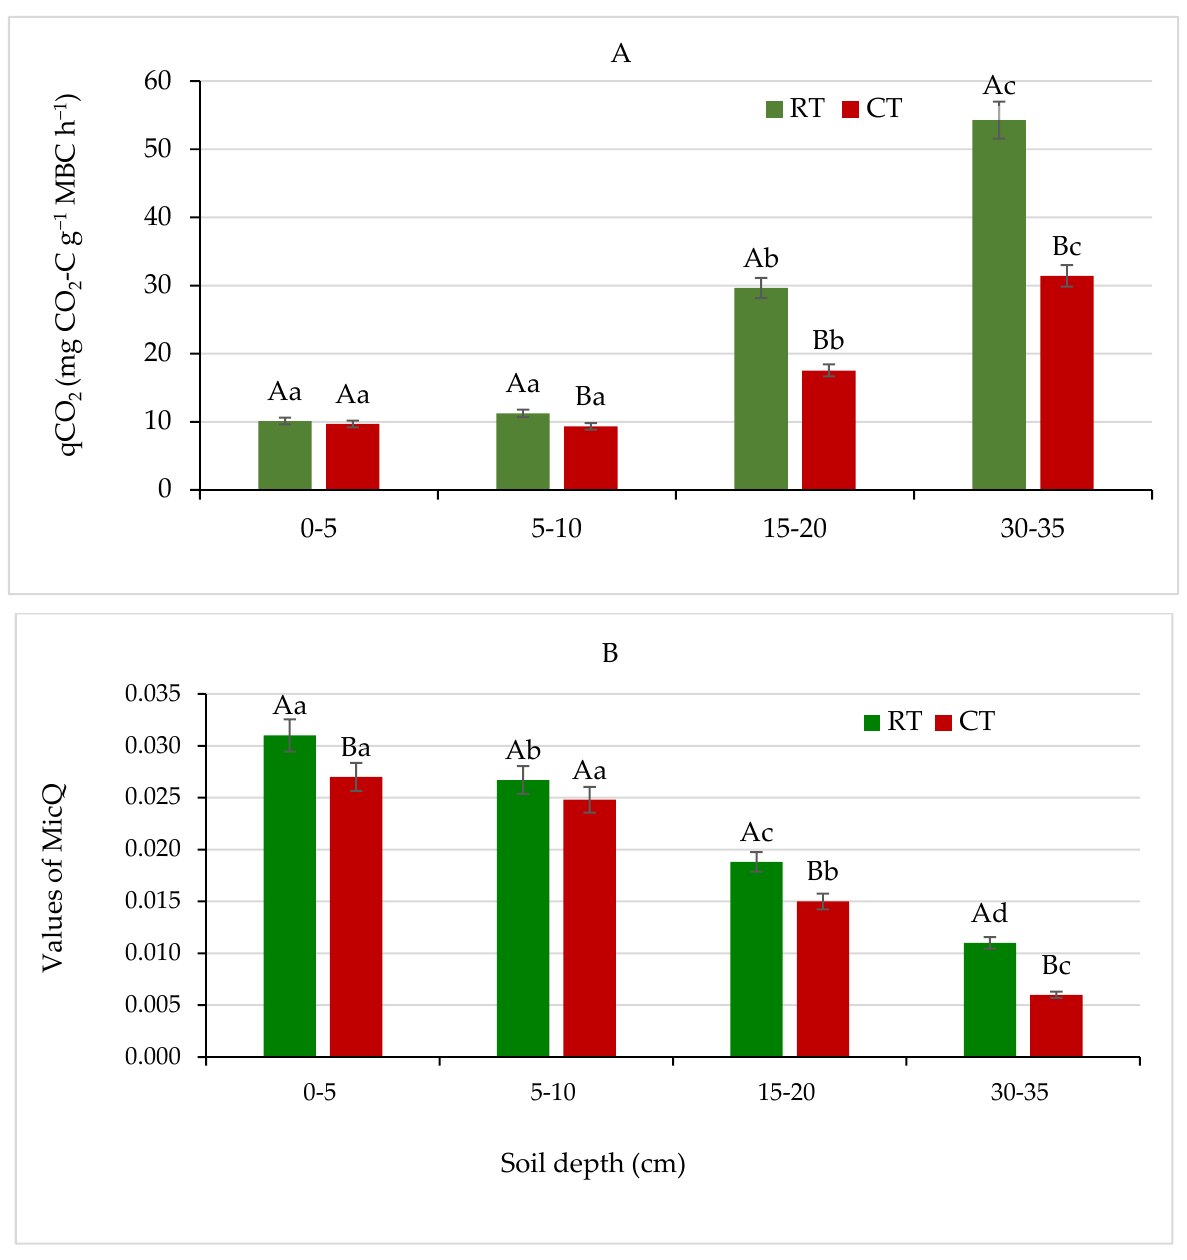
Figure 12. ( A ) Metabolic quotient (qCO 2 ), and ( B ) microbial quotient (MicQ) for soil under different tillage systems in 2018–2020 (expressed as means for the 3 years, n = 12). Different letters represent significant differences ( p ≤ 0.05) across treatments according to Tukey’s HSD test; lowercase letters within the same tillage system indicate significant differences between soil depths; uppercase letters indicate differences between tillage systems. RT—reduced tillage system; CT—conventional tillage system; d.w.—dry weight of soil; n— number of samples. Vertical bars represent standard errors.